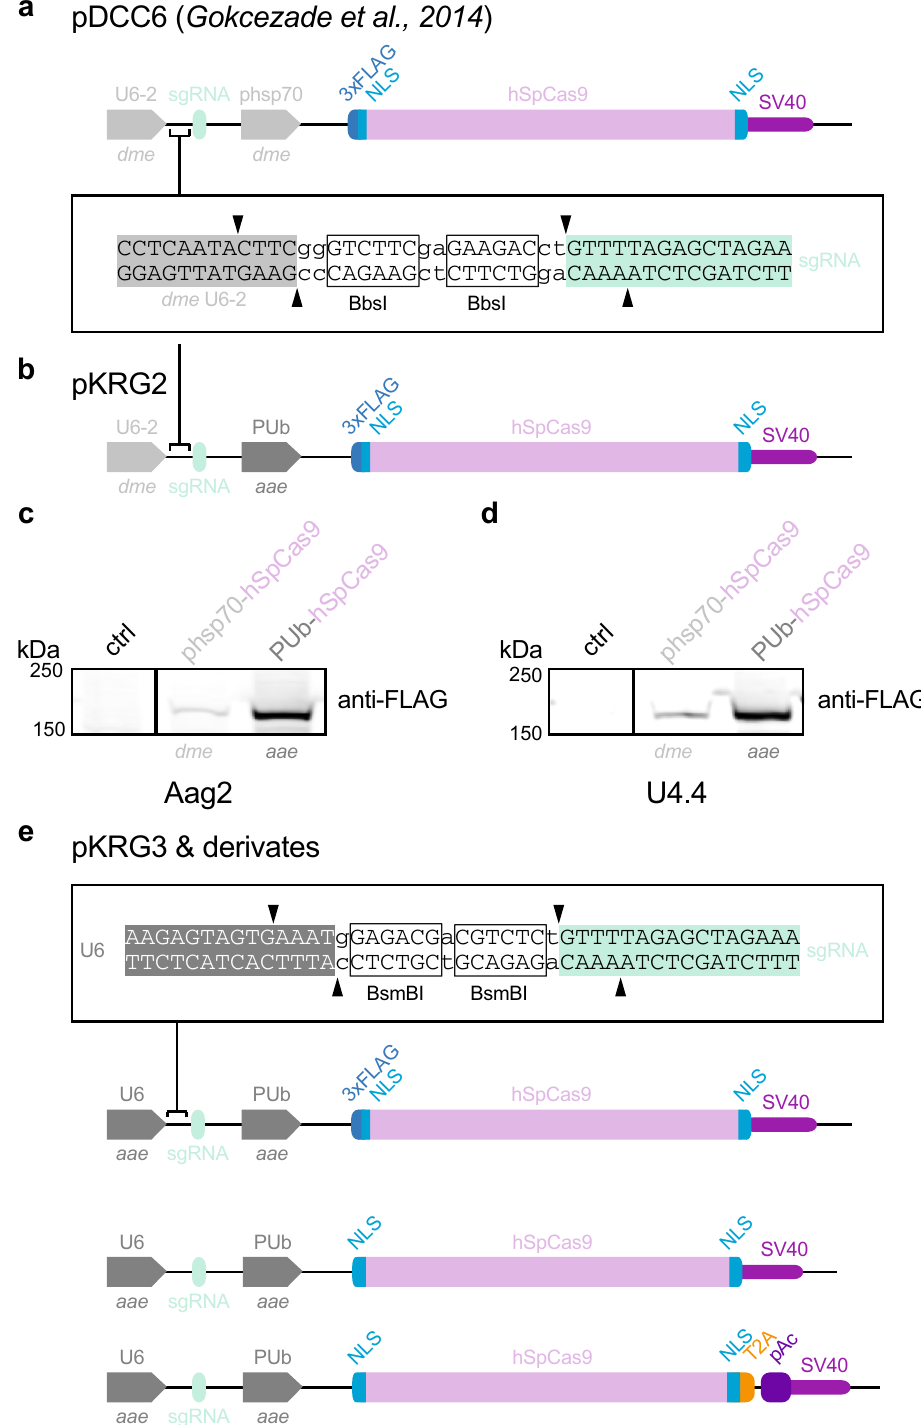
Figure 1. Mosquito optimized CRISPR/Cas9 plasmids. ( a ) pDCC6 plasmid published in Gokcezade et al. 29 . The dme U6-2 promoter drives sgRNA transcription and the dme phsp70 promoter drives expression of a 3xFLAG-tagged hSpCas9. Guide RNAs are cloned by BbsI digest. ( b ) pKRG2 plasmid, generated by replacing the dme phsp70 promoter with the aae PUb promoter. Cloning of guide RNAs as in ( a ). ( c ) Immunoblot of Aag2 cells treated with transfection reagent (ctrl) or